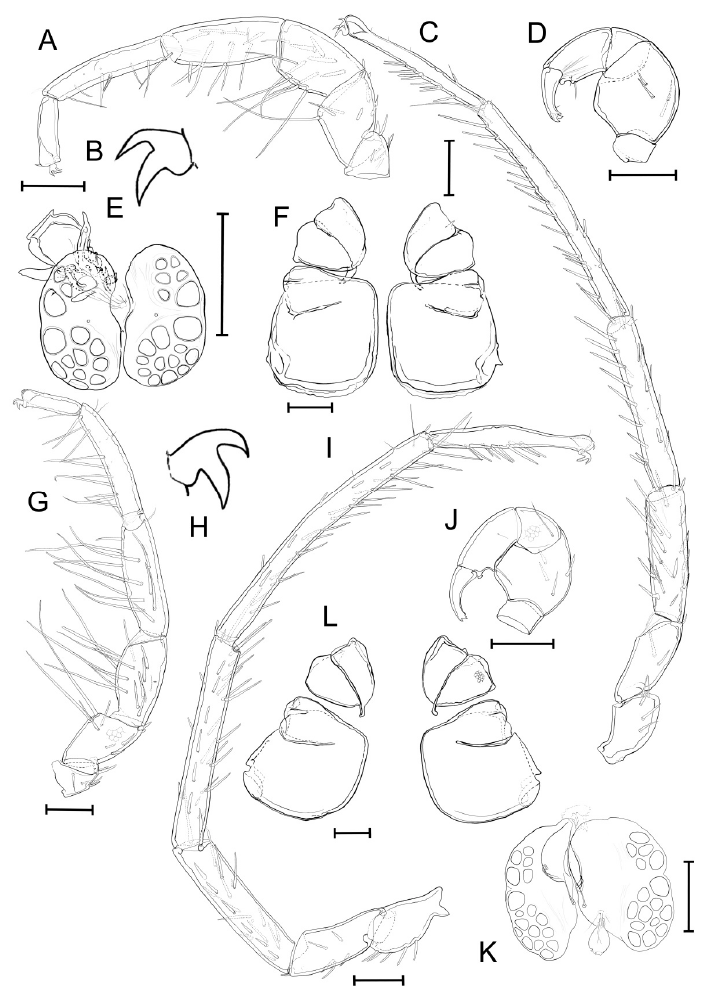
Figure 6. Unionicola ( Myanmaratax ) generosa sp. nov. The male, slide RMBH Hyd 413: ( A ) I-L, ( B ) claw of I-L, ( C ) IV-L, ( D ) P, ( E ) genital field, and ( F ) coxal plate. The female, slide RMBH Hyd 413: ( G ) I-L, ( H ) claw of I-L, ( I ) IV-L, ( J ) P, ( K ) genital field, and ( L ) coxal plate. Scale bars = 100 μ m. (Graphics: Yulia E. Chapurina).